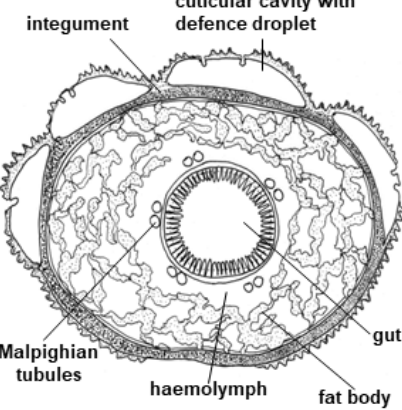
Figure 14. Cross section of Z. filipendulae larva adapted from [42].